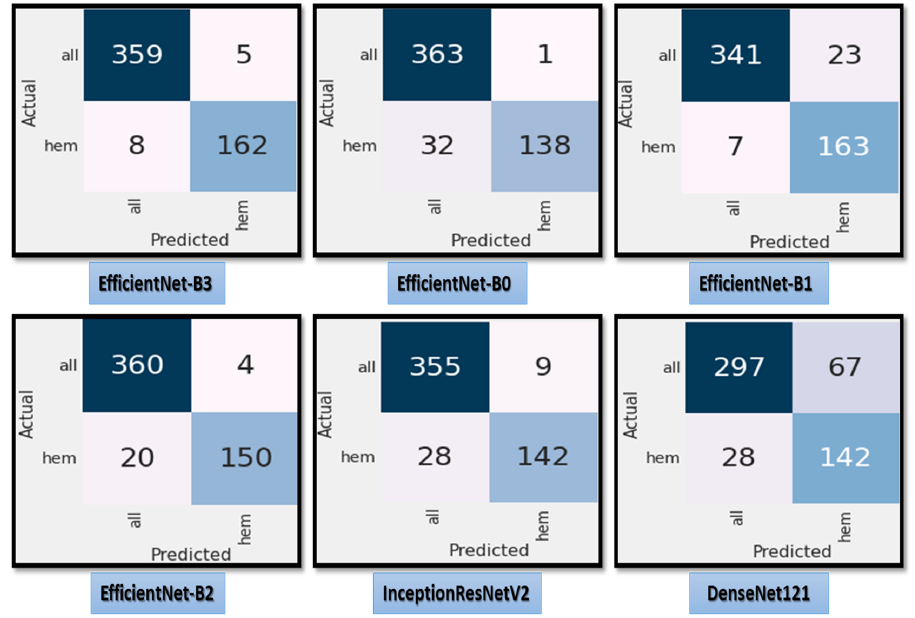
Figure 7. The test dataset’s confusion matrix for the six CNN models using a fixed LR. Table 3. Performance of the six CNN models using the proposed dynamic LR. Model